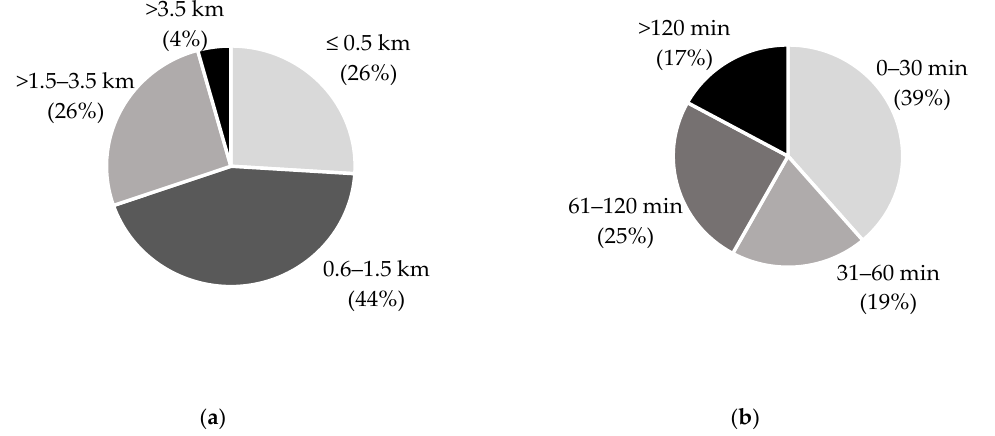
Figure 4. ( a ) Distance of previous drinking water source and ( b ) amount of time spent collecting water for domestic use before installing the RWH system. The values in the parenthesis indicate the proportion of households.